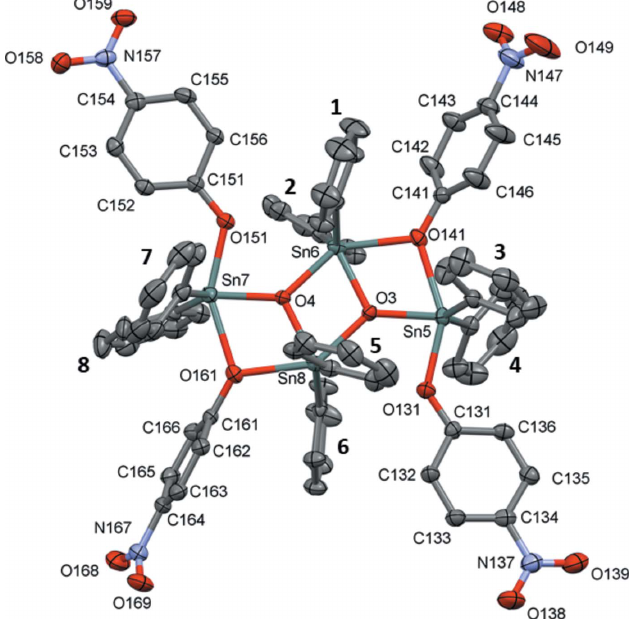
Figure 2 The molecular structure of complex B . Displacement ellipsoids are drawn at the 30% probability level. Phenyl ring 1 = C171–C176, 2 = C181–C186, 3 = C191–C196, 4 = C201–C206, 5 = C211–C216, 6 = C221–C226, 7 = C231–C236, 8 = C241–C246. For clarity, the hydrogen atoms have been omitted.